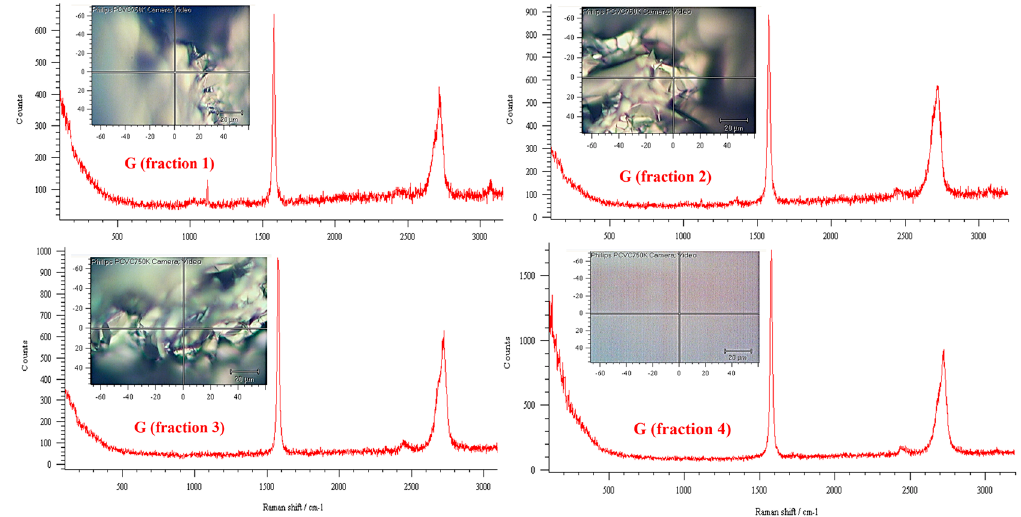
Figure 2. Raman spectral mapping of unfunctionalized G nanofiller.